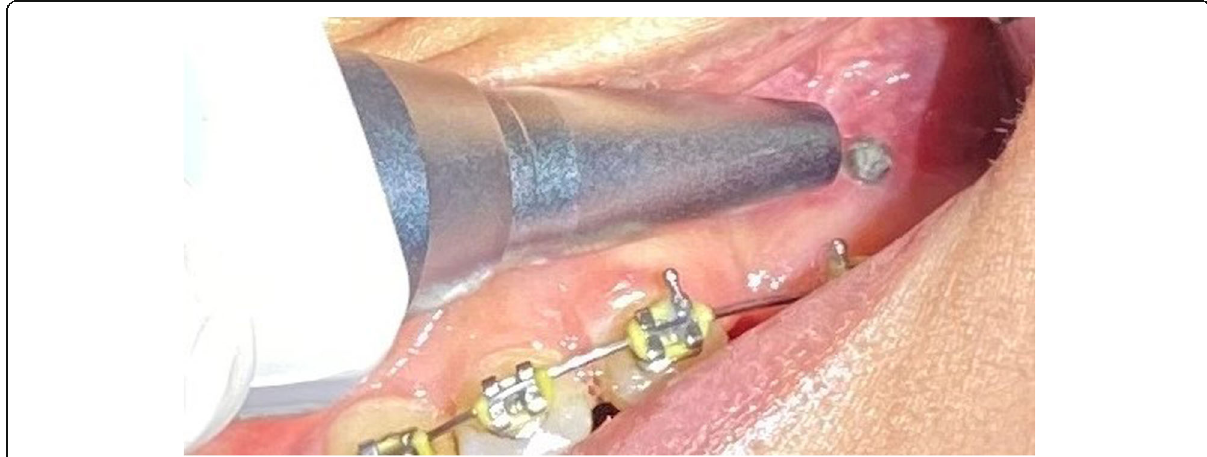
Fig. 3 Periotest was held perpendicular to the longitudinal axis of the miniscrew to evaluate its